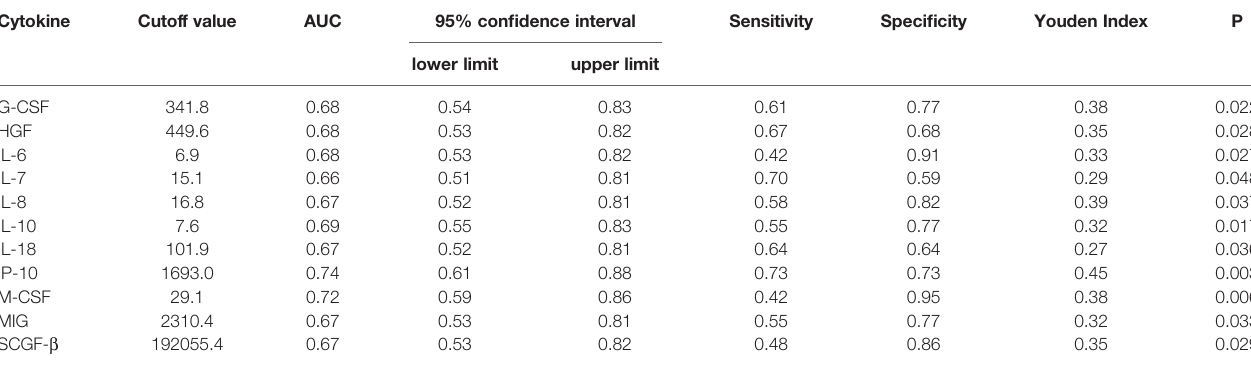
TABLE 4 | Receiver operating characteristic (ROC) curve analysis by cytokines for COVID-19 patients to predicting severity of the disease. Cytokine Cutoff value